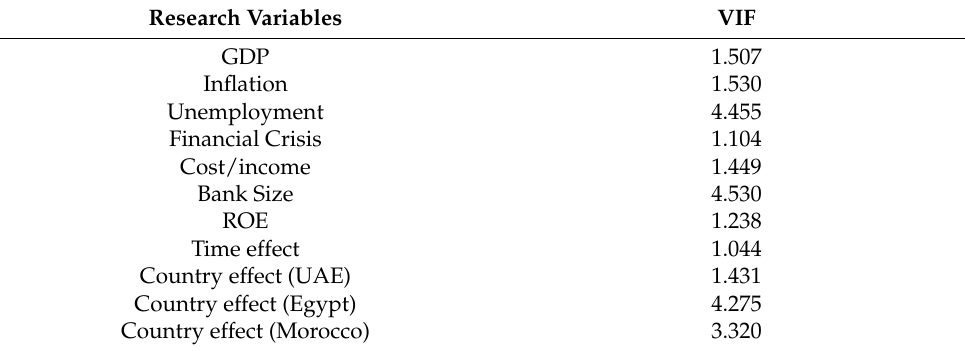
Table A1. Test of